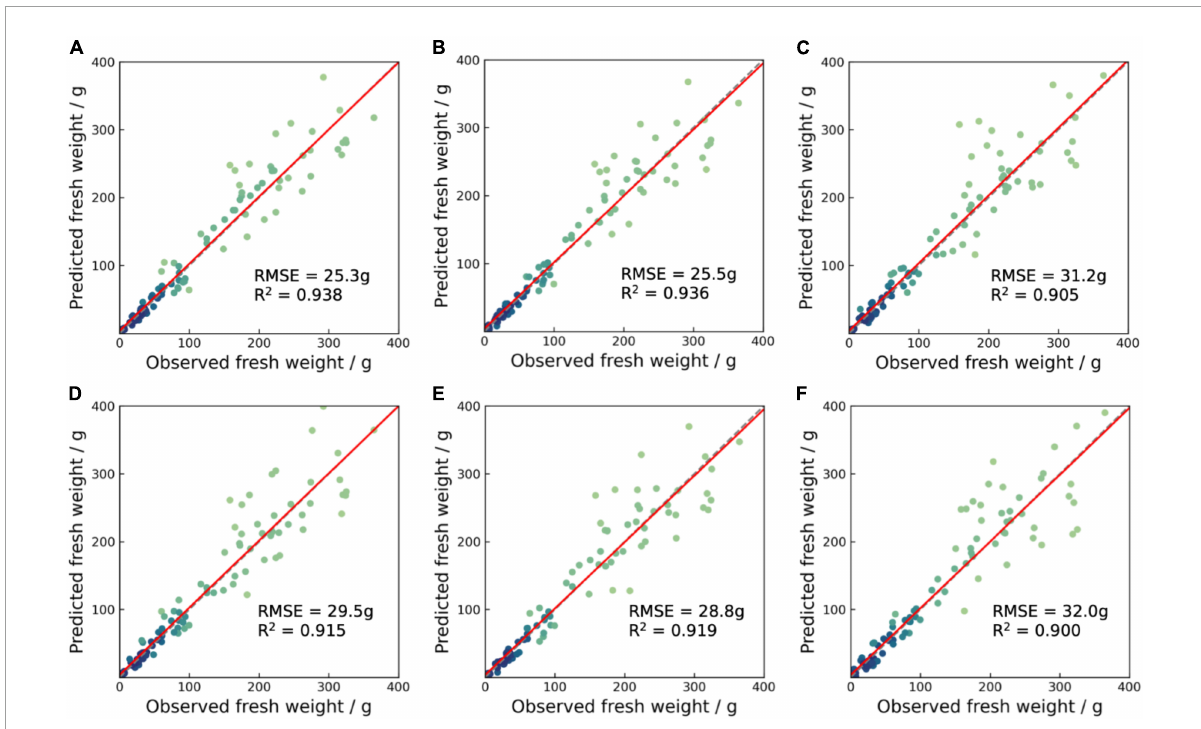
FIGURE7 Scatter plots between predicted and observed fresh weight for the test set of augmented models (A) RGB + D + G, (B) RGB + G, (C) D + G, (D) RGB + D, (E) RGB only, and (F) D only. The red solid lines represent the fitting lines, and the gray dotted lines represent the 1:1